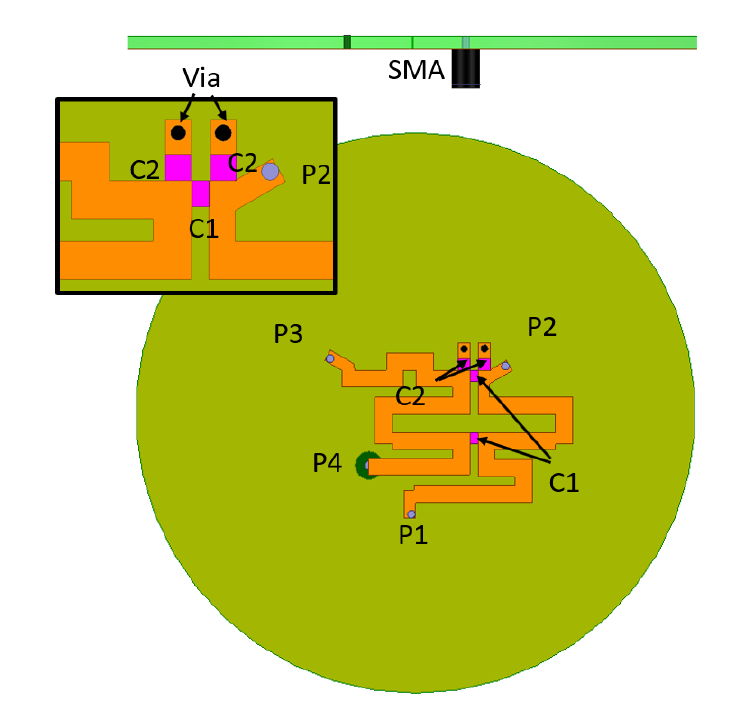
Figure 4. Top and side of the feeding circuit.